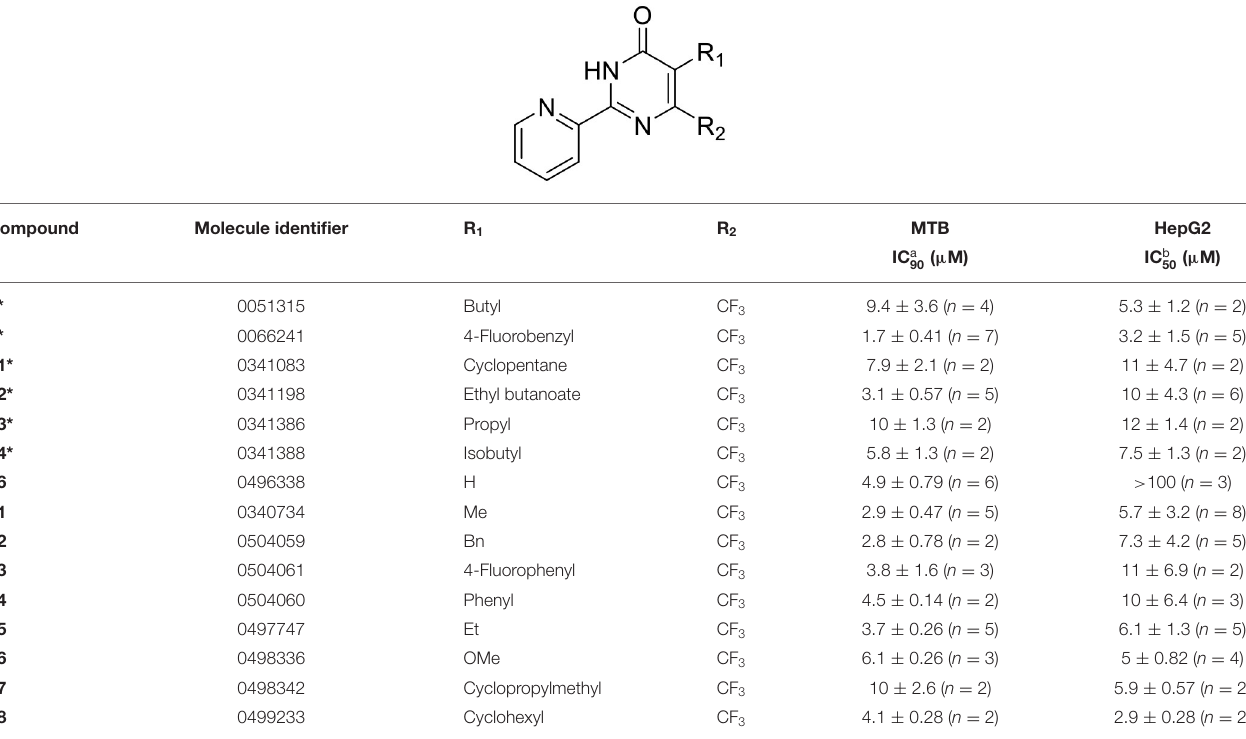
TABLE 4 | Activity of compounds with 5/6-position substitutions of the 2-(pyridin-2-yl)pyrimidin-4(3H)-one.